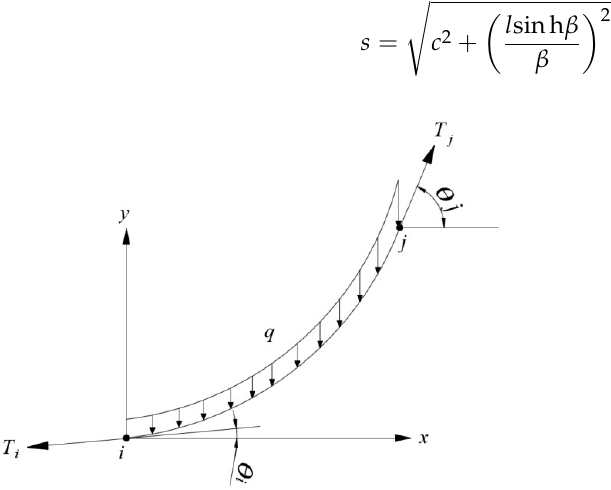
Figure 2. Local coordinate system of the